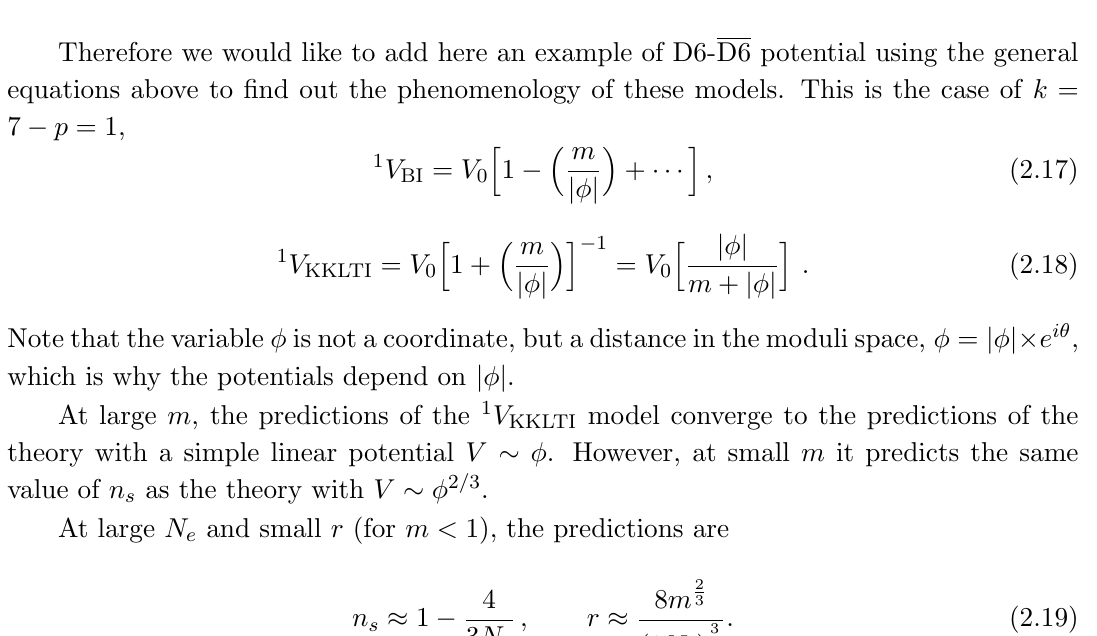
Figure 6 . Exchange of a closed string between two D-branes. Equivalently, a vacuum loop of an open string with one end on each